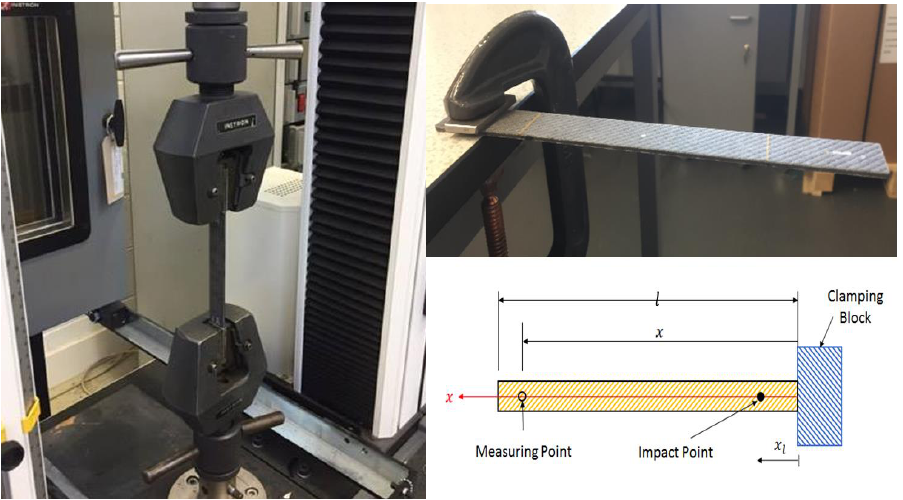
Figure 2. The test set up for tensile samples mounted on the Instron 3382 ( left ) and the cantilever beam set up for damping experiments ( right ) .